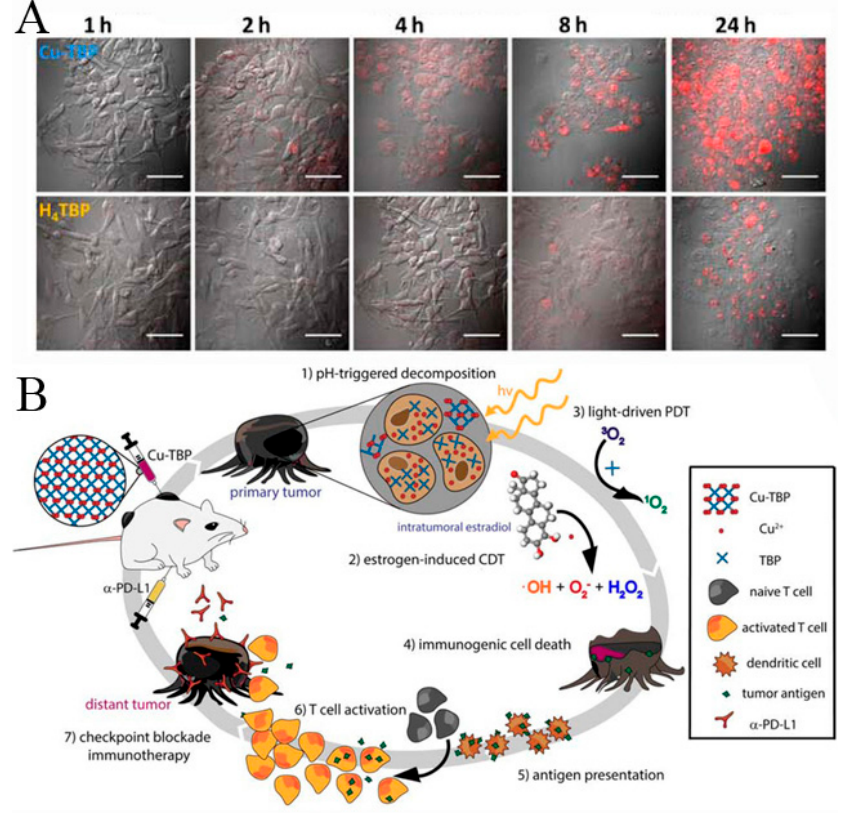
Figure 2. ( A ) B16F10 cellular uptake of Cu-TBP or H 4 TBP at different time-points after incubation with equivalent TBP concentrations of 20 mM observed by confocal imaging. Free H 4 TBP emits red fluorescence. Scale bar, 50 µ m. ( B ) Synergy of Cu-TBP mediated radical therapy stimulated by hormone, light and checkpoint blockade immunotherapy. Reprinted with permission from Ref. [54]. Copyright 2019, Elsevier.